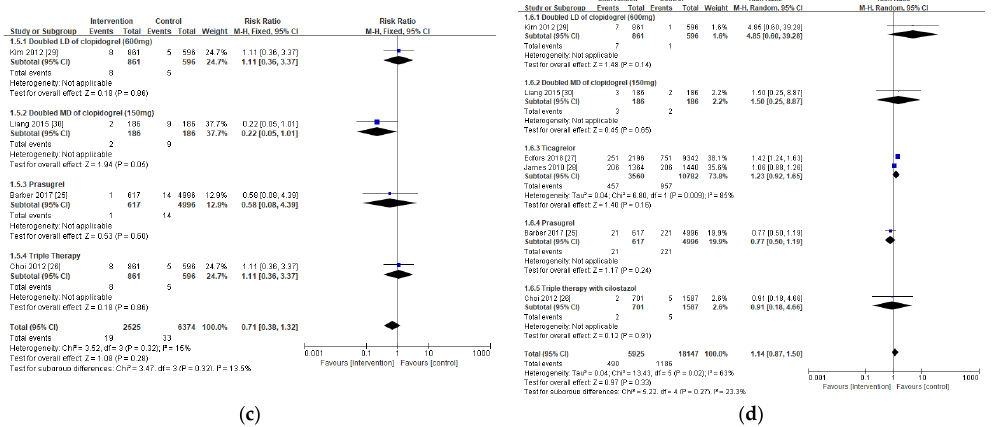
Figure 3. Forest plots of clinical outcomes in CKD patients from antiplatelet therapy: ( a ) major adverse cardiovascular events (MACE); ( b ) myocardial infarction (MI); ( c ) stent thrombosis; and ( d ) major bleeding risks. Blue indicates the risk ratio evaluated from each study and black indicates the overall risk ratio of the antiplatelet regimen.